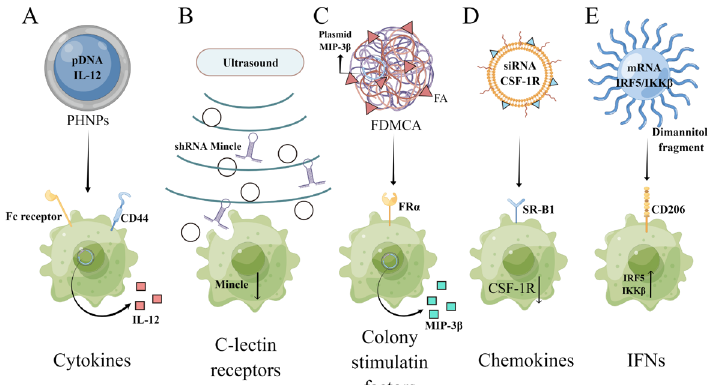
Figure 5. The therapeutic targets in TAMs and the corresponding nucleic acid therapeutics. PHNPs: porous hollow nanoparticles; Fc: crystallizable fragment; Mincle: macrophage-inducible C-type lectin; MIP-3β: macrophage inflammatory response protein 3β; FRα: folate receptor alpha; SR-B1: scavenger receptor B type 1; IRF5: interferon regulatory factor 5; IKKβ: inhibitor of kappa B kinase; FDMCA: FA-modified poly(ethylene glycol)-polycaprolactone-methoxy poly(ethylene glycol) (MPEG)-polylactic acid.